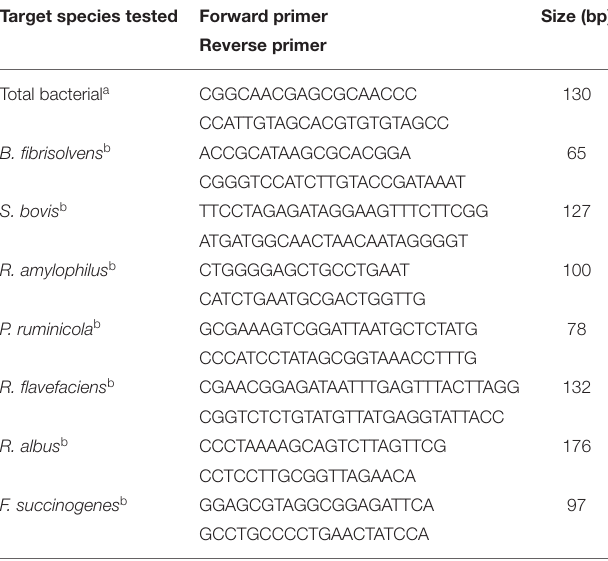
TABLE 2 | Primers used for RT-PCR detection of microbial